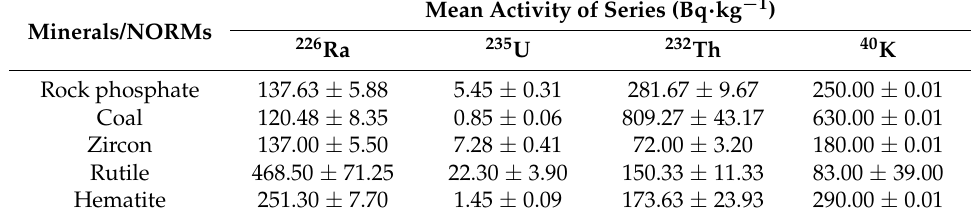
Table 3. Mean activity concentration of 226 Ra, 232 Th decay series and 40 K in rock phosphate, coal, zircon, rutile and